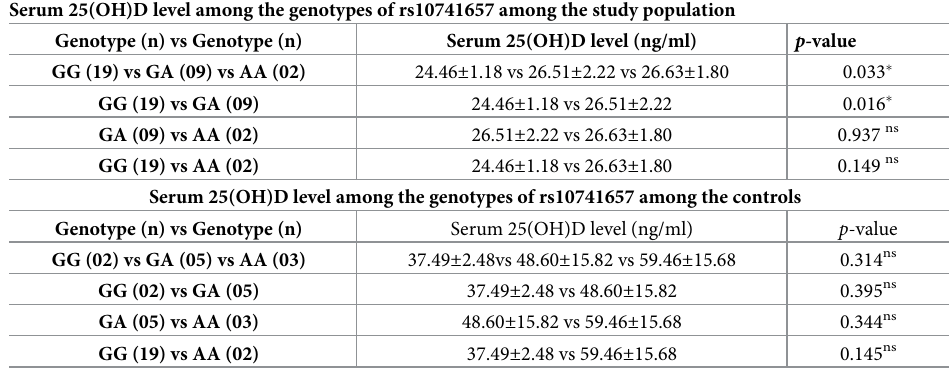
Results were expressed as Mean ± SD. One way ANOVA followed by LSD test was performed to compare between groups; N = Total number of study population, n GG = number of genotype GG, n GA = number of genotype GA, n AA = number of genotype AA; The test of significance was calculated for all comparisons and p value < 0.05 was